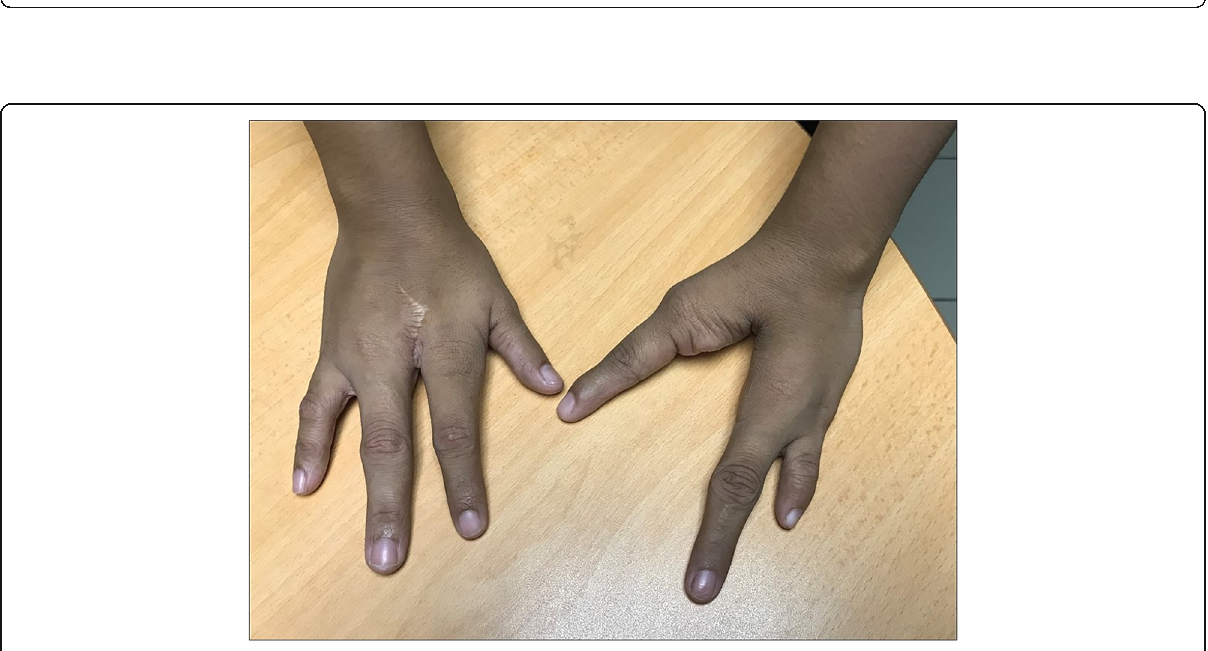
Fig. 2 Radiological images of the upper limbs and pelvis of the proband showing complete absence of the metacarpal and the phalanges of the third digit on the left hand and absent metacarpals and phalanges of two digits on the right hand. Rest of the upper limbs and upper femur were radiologically normal